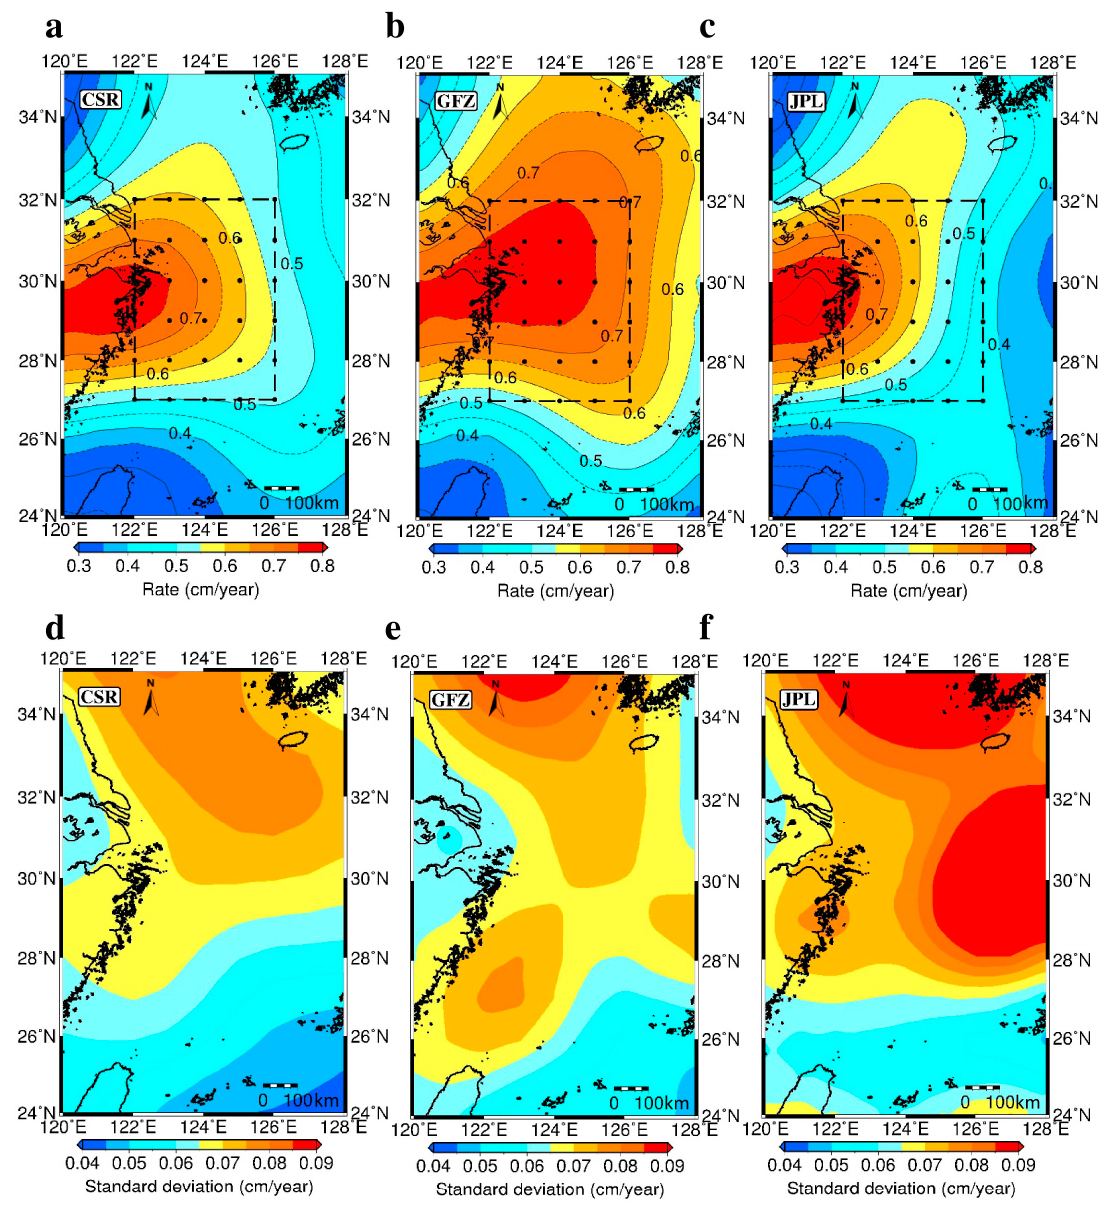
Figure 5. GRACE-derived sediment mass accumulation rates (MARs) (EWH rates) from ( a ) CSR; ( b ) JPL and ( c ) GFZ over April 2002–March 2015; and ( d – f ) are the standard deviations of the rates. The dashed boxes contain the area (27–32 ◦ N, 122–126 ◦ E) where the area-averaged EWHs in Figure 4 are